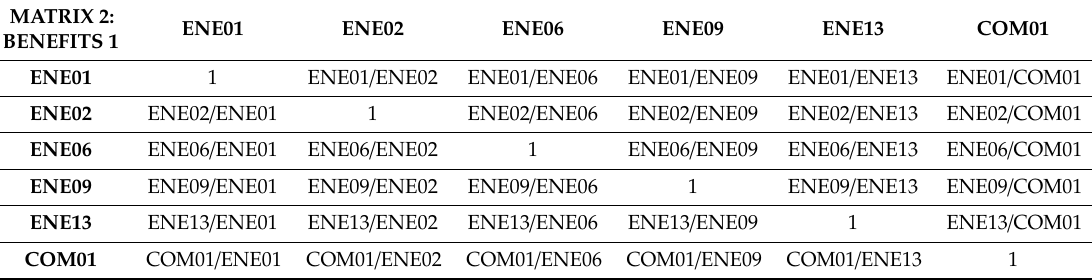
Table 4. Pairwise comparison matrices for Matrix 2 (Benefits Level